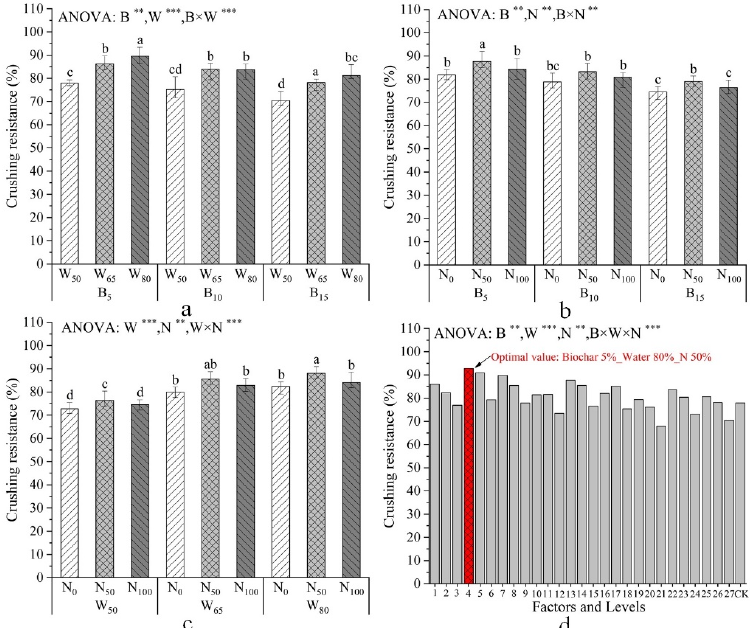
Figure 4. Effects of crushing resistance of seedling pot with different treatments of seedlings: ( a ) Interaction between biochar and water content; ( b ) Interaction between biochar and N; ( c ) Interaction between water content and N; and ( d ) Interaction between biochar, water content, and N. Note: Values with different lower case letters were used in the same column to indicate the significance of the difference when p < 0.05; *** ( p < 0.001), ** ( p < 0.01) were used to indicate whether there was remarkable difference between different treatments.